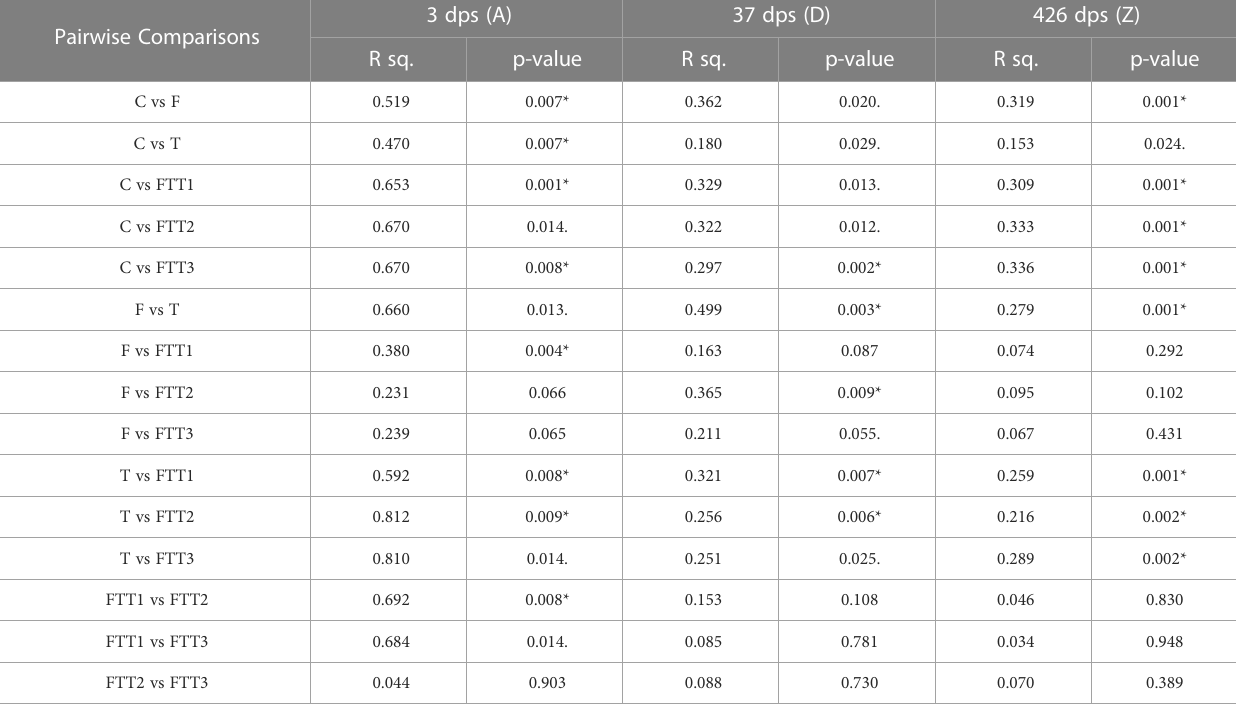
TABLE 1 A pairwise PERMANOVA was run between each treatment to quantify if fungal community composition was different at each time point during soil recovery (3dps, 37dps, and 426dps).